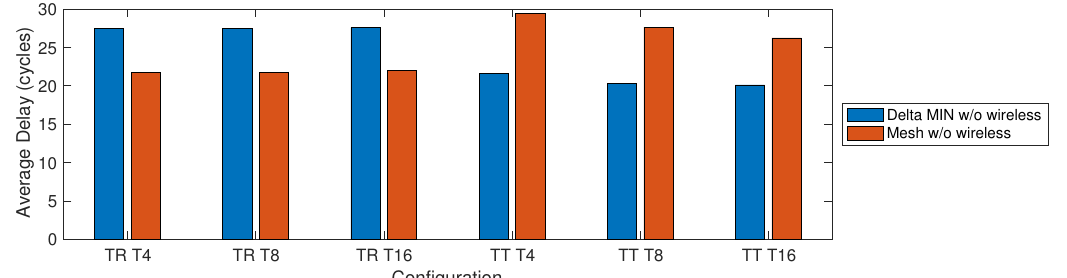
Figure 20. Average delay (cycles) in non-saturated conditions for Delta MIN and mesh topologies of size 64.